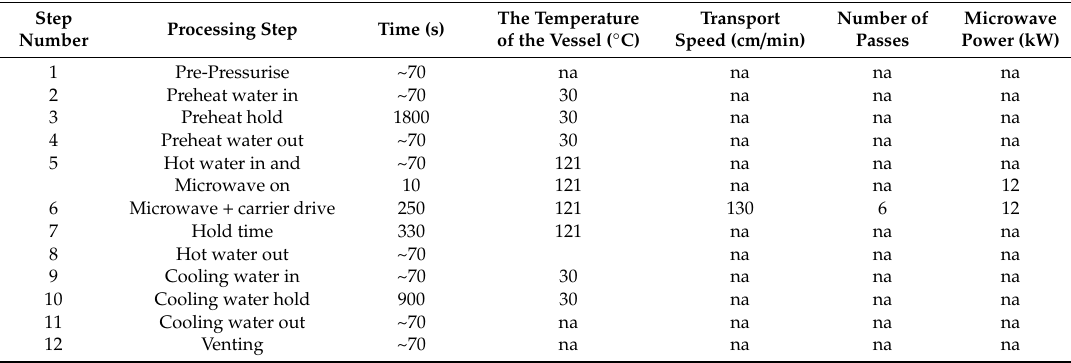
Table 1. The processing steps for R121.